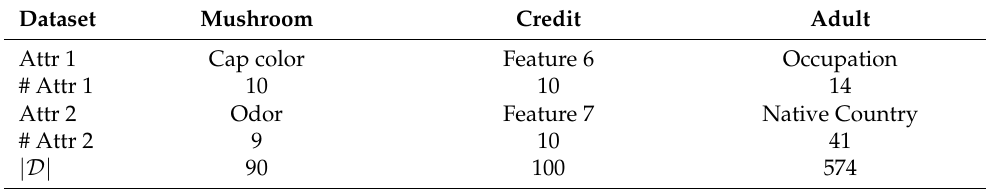
Table 7. Details of datasets used in benchmarking the secure federated χ 2 -test on various datasets.